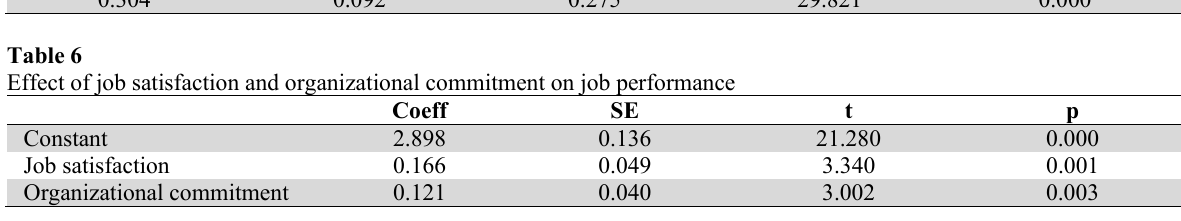
Indirect Effect (Sobel test)